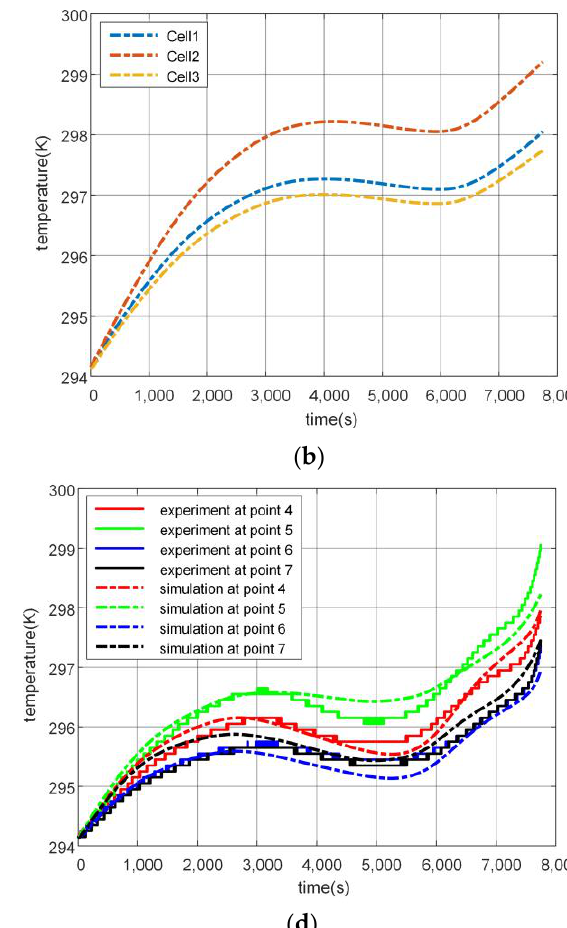
Figure 7. Curves of parameters R condx and R condy. To verify simulation accuracy, a 20 A constant-current discharge experiment was conducted at a constant temperature of 293.15 K, and the connection mode and tempera- ture acquisition points are shown in Figure 8.